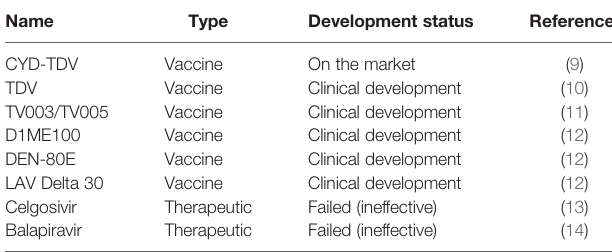
TABLE 1 | Dengue vaccines and